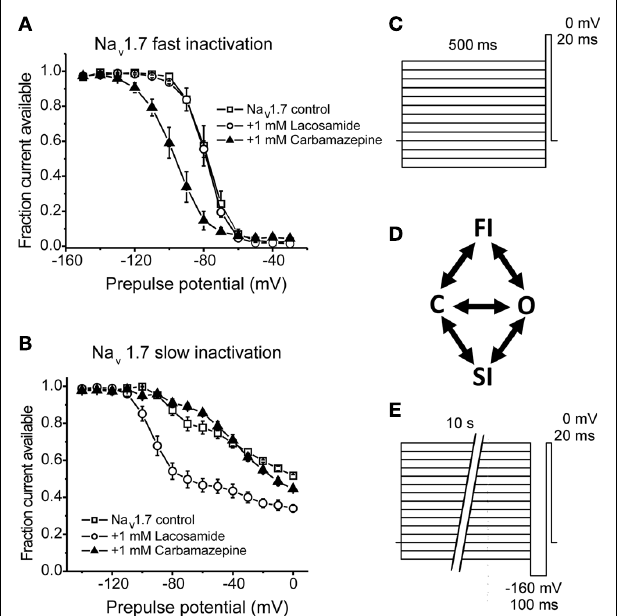
FIGURE 3 | Lacosamide enhances sodium channel slow-inactivation without altering fast inactivation. (A) Carbamazepine, but not lacosamide, enhances Nav1.7 fast inactivation as evident by a hyperpolarizing shift in the voltage-dependence of steady-state fast inactivation. (B) Lacosamide, but not carbamazepine, causes a significant shift in the voltage-dependence of Nav1.7 slow-inactivation. (C,E) Pulse protocols for determining the voltage-dependence of fast and slow-inactivation, respectively. (D) A simplified diagram showing the different channel occupancy states, where C indicates the closed-state, O the open state, FI the fast-inactivated state and SI the slow-inactivated state. (A,B) adapted from Sheets et al. (2008) with permission from The Journal of Pharmacology and ExperimentalTherapeutics .